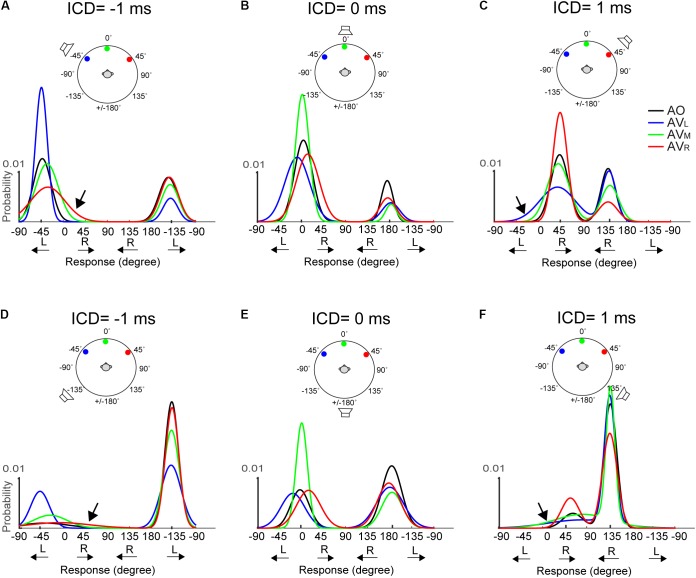
Two-peak Gaussian functions for AO and AV responses at the 15-ms condition. The top (A–C) and bottom (D–F) rows show the results obtained using the two frontal or rear speakers, respectively. Each curve was obtained by fitting the data from all trials and all subjects using the Gaussian Mixture Model (see section “Materials and Methods” for detail). The stimulus configuration in terms of ICD and lighting conditions is illustrated above the results on each panel; the speaker sign marks the quasi-vertical response position. The AO results (black) show that at ICD of –1 ms, the responses were clustered on the left side at –45 and –135 degrees, at ICD of 0 ms, the responses were clustered on the midline at 0 and ±180 degrees, and at ICD of 1 ms, the responses were clustered on the right side at 45 and 135 degrees. The color lines show changes in the left–right and front–back responses after adding visual stimulation.